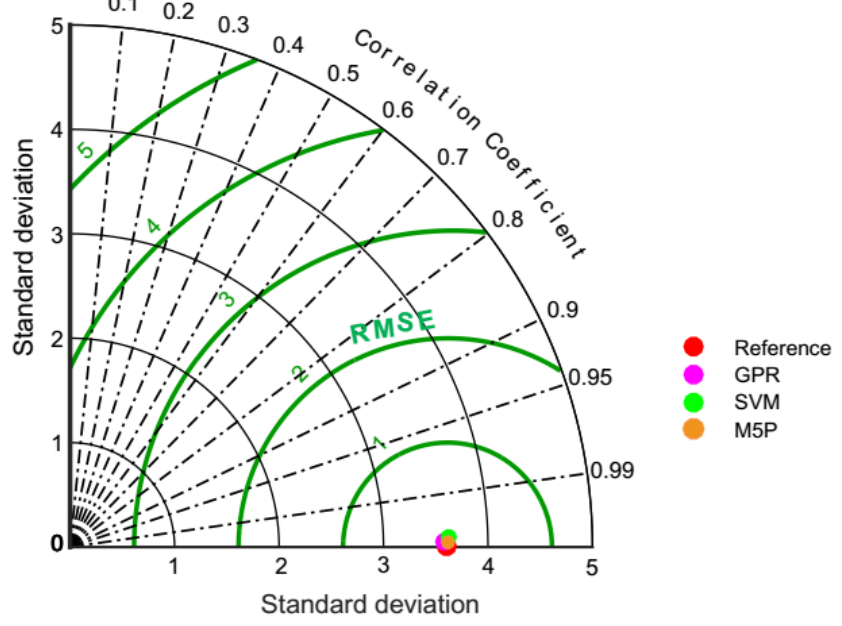
Figure 6. Taylor diagram of GPR, SVM, and M5P predicted models.